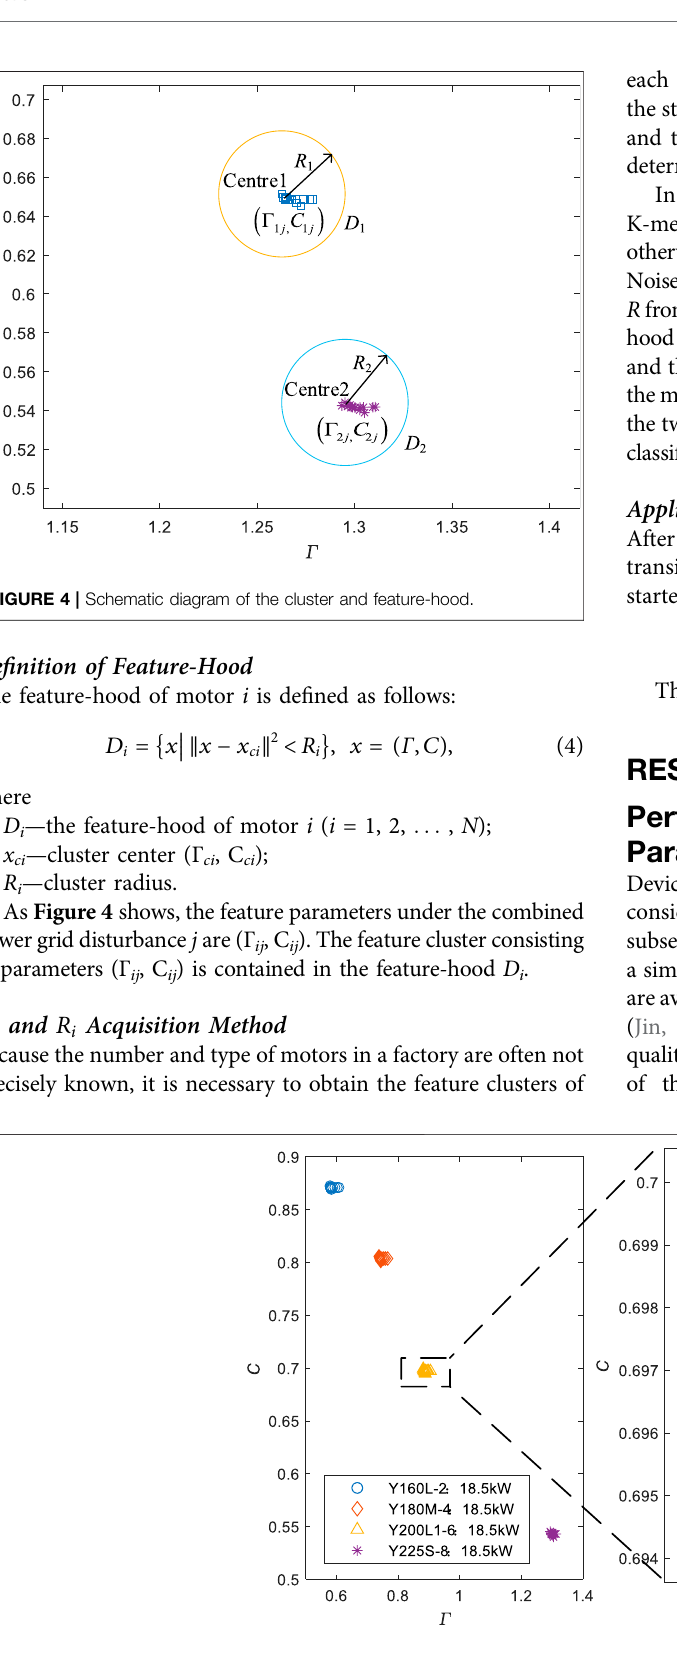
FIGURE 5 | Distribution of feature parameters of motors with the same rated power but a different number of poles.